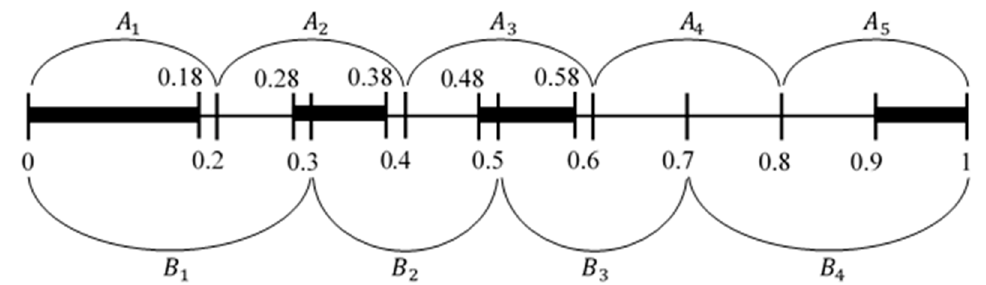
Figure 2. Information sets for more complex example.